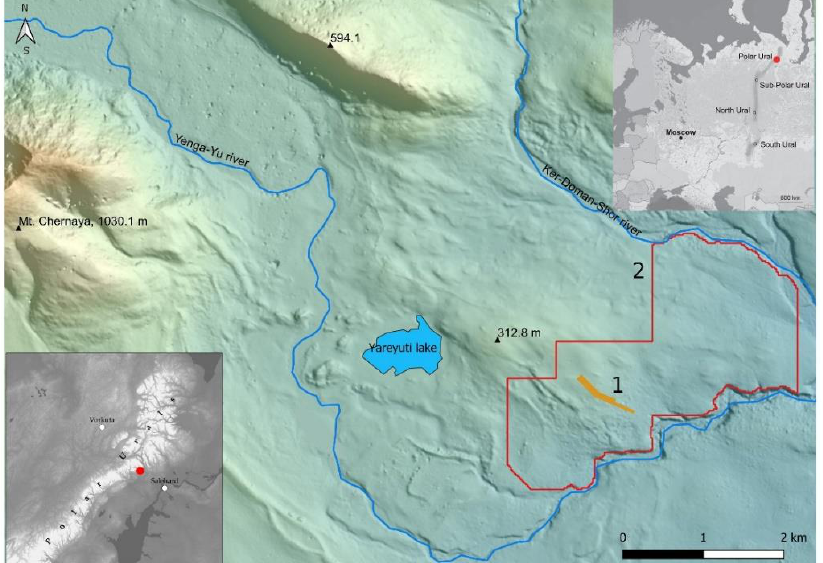
Figure 1. Location of the Polar Urals (right inset), the studied area within a region (left inset), monitoring altitudinal transect (1) and test polygon, (2) and on the southern and eastern slopes of a hill with a height mark of 312.8 m a.s.l., close to Mount Chernaya.